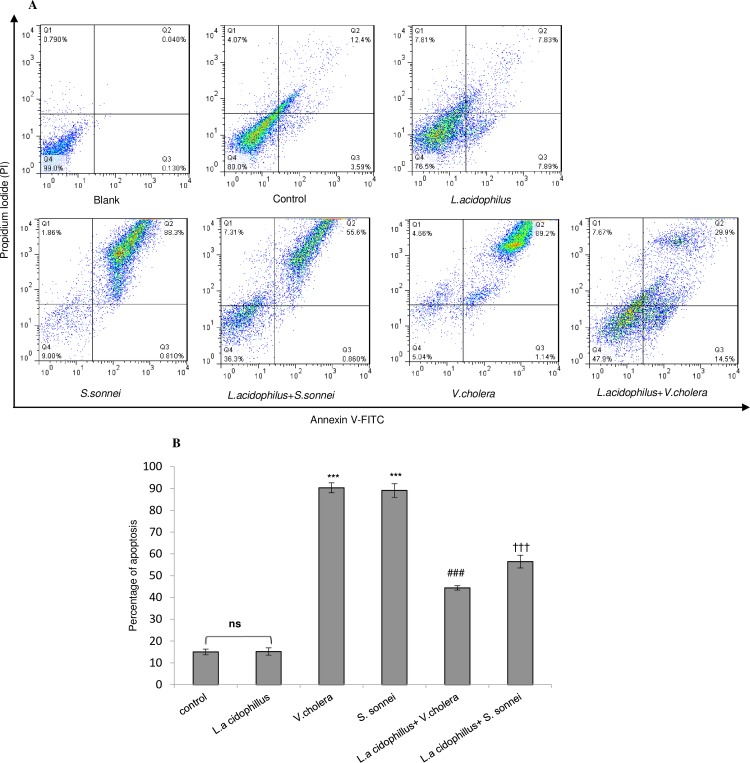
Annexin V-FITC/PI staining and flow cytometry assay to determine the proportion of apoptosis after pretreatment of Caco-2 cells with L. acidophilus and then infected by V. colarae/ S. sonnei.Images showed the typical morphologies of cells in the different regions. (A) Q1: Necrotic cells, Q2: Late apoptotic cells, Q2: Early apoptotic cells and Q4: Viable cells. L.a: Lactobacillus acidophilus, V.c: Vibrio cholerae and S.s: Shigella sonnei. (B)The pretreatment with L. acidophilus on Caco-2 cells exposed to V. colarae/ S. sonnei resulted in decreased apoptosis. Statistical analysis of representative images was performed with three independent experiments. The statistical significances were achieved when P <0.05 (***P <0.001). *** significantly different from control cells. ### significantly different of L.a+V.c+Caco-2 from V.c+Caco-2 cells. ††† significantly different of L.a+S.s+Caco-2 from S.s+Caco-2 cells L.a: Lactobacillus acidophilus, V.c: Vibrio cholerae and S.s: Shigella sonnei. ns: none significant.